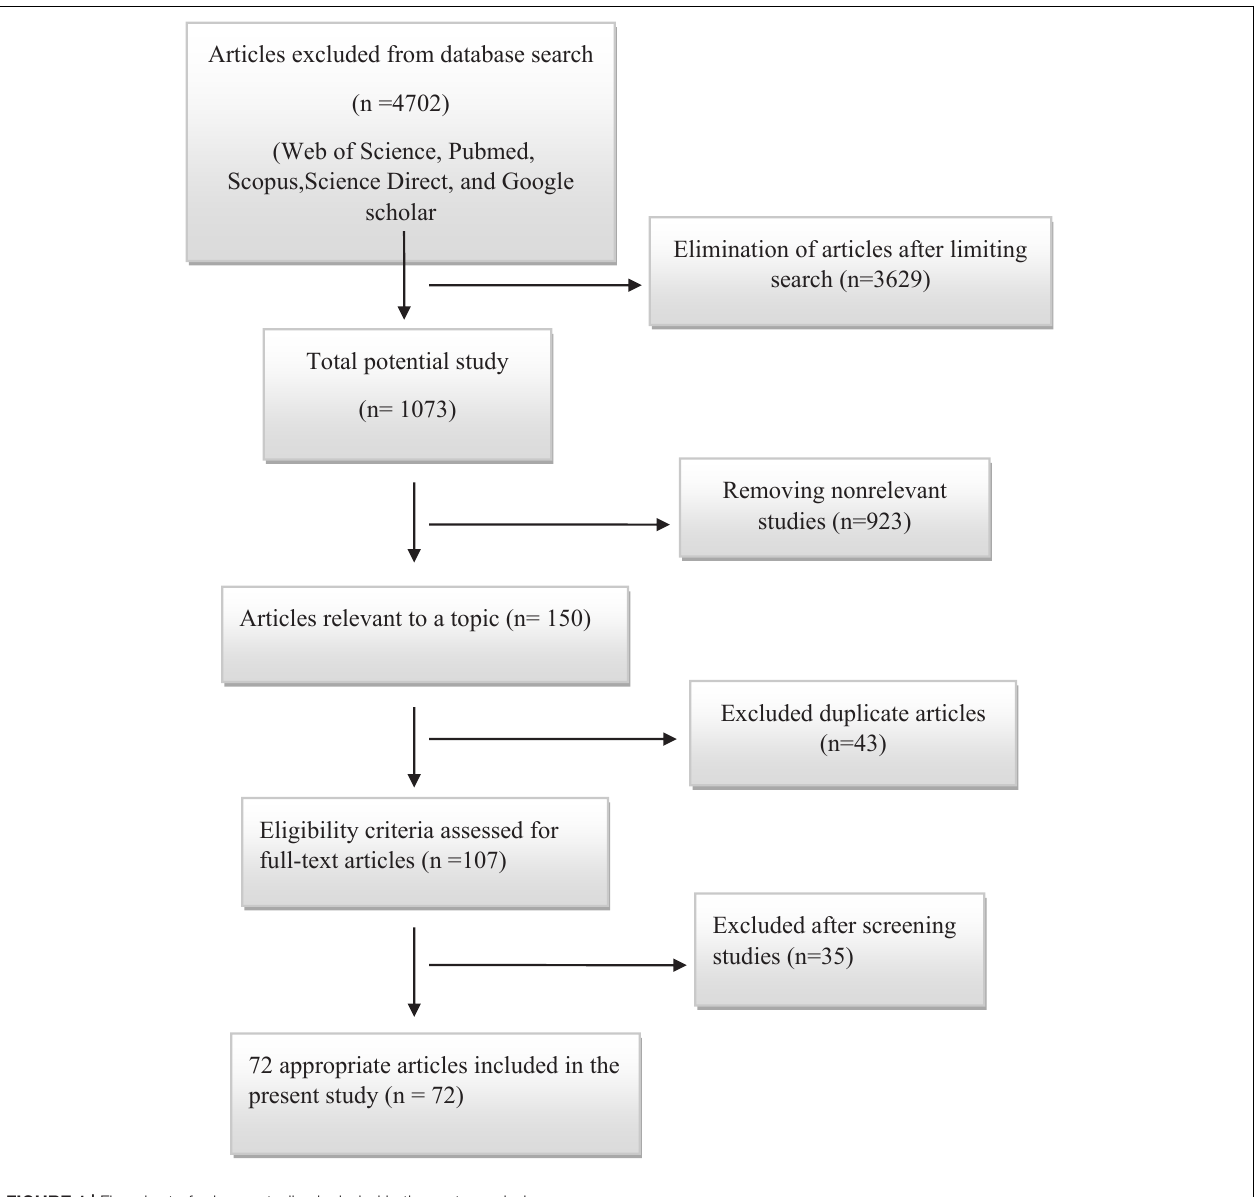
FIGURE 1 | Flowchart of primary studies included in the meta-analysis.